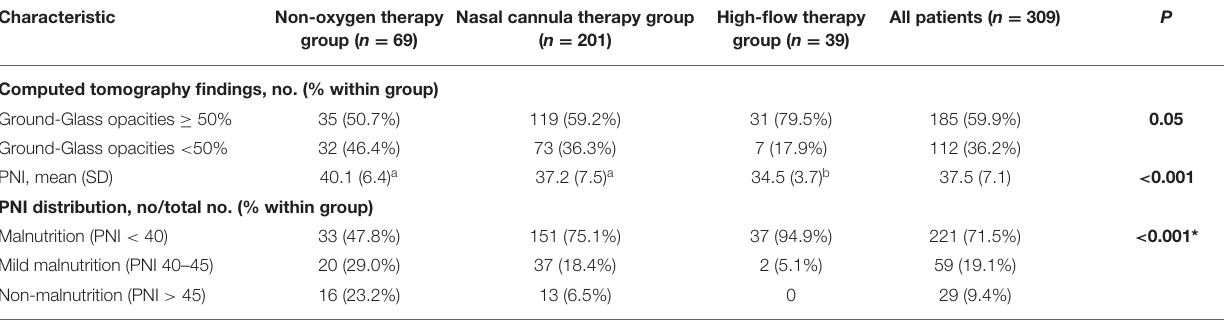
TABLE 2 | Estimate for hospital length of stay according to oxygen therapy requirement and Prognostic Nutritional Index (PNI) categories. Hospital length of